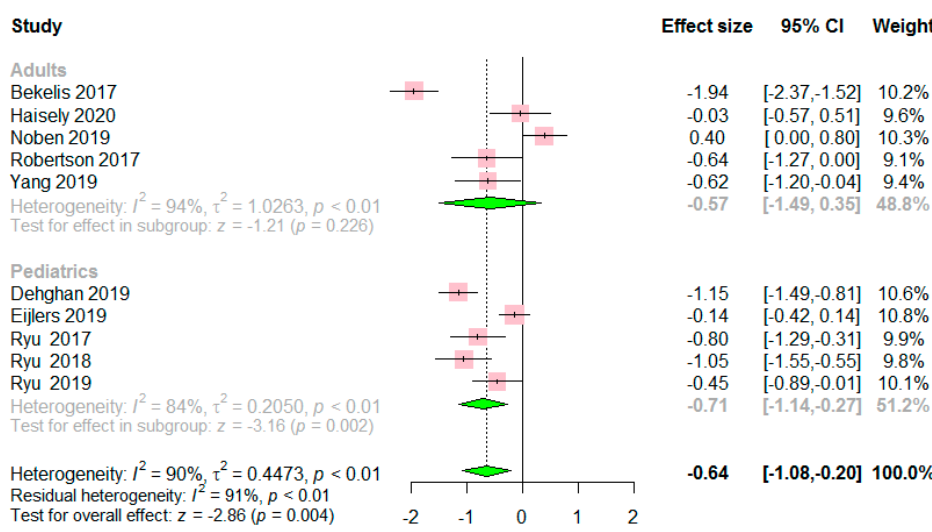
Figure 2. Forest plot comparing the preoperative anxiety score between the VR group and the control group. The preoperative anxiety score was significantly lower in the VR group than in the control group ( p = 0.004). In subgroup analysis, the preoperative anxiety score was lower in the VR group than in the control group in pediatric patients ( p = 0.002), while significant difference was not found between the VR group and control group in adult patients ( p = 0.226). Table 2. Meta-regression for the potential sources of heterogeneity.